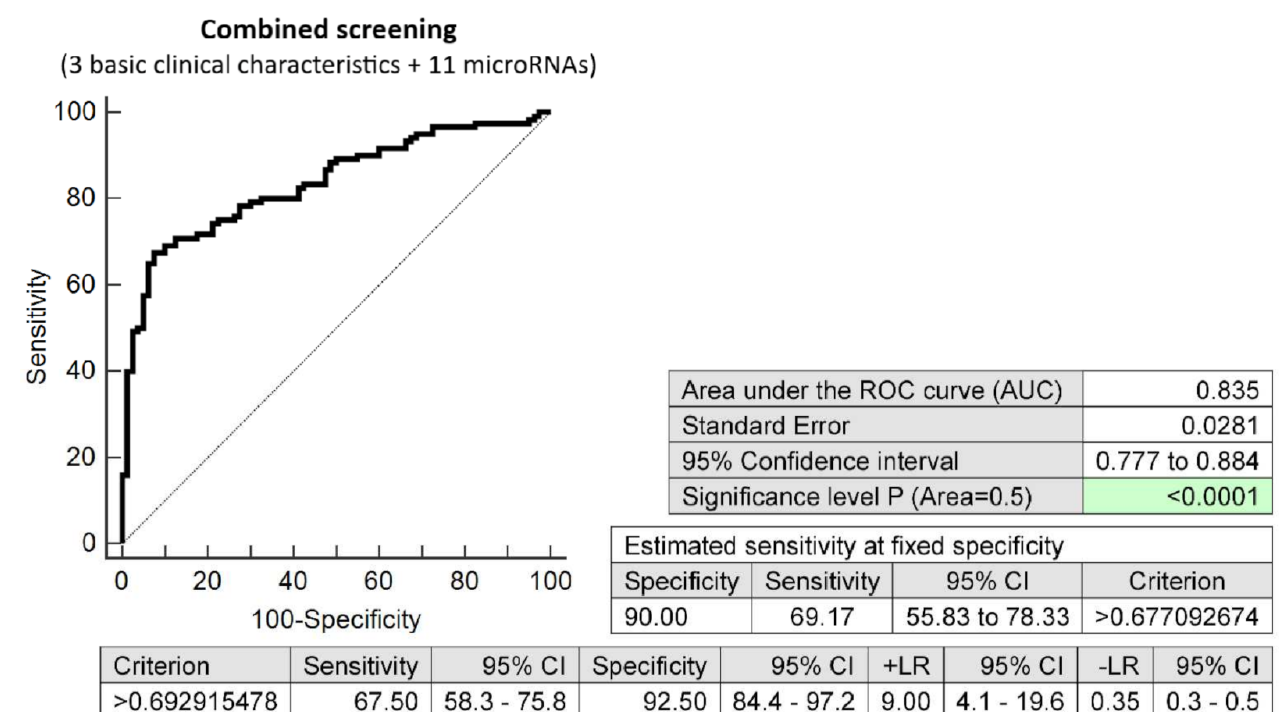
Figure 3. ROC analysis—the combination of 3 basic clinical characteristics (maternal age and BMI values at early stages of gestation and an infertility treatment by assisted reproductive technology) and 11 dysregulated microRNA biomarkers (miR-1-3p, miR-20a-5p, miR-20b-5p, miR-23a-3p, miR- 100-5p, miR-125b-5p, miR-126-3p, miR-181a-5p, miR-195-5p, miR-499a-5p, and miR-574-3p). At a 10.0% FPR, 69.17% of pregnancies destinated to develop GDM were identified during the first trimester of gestation. This represents 84 out of 121 pregnancies correctly predicted to develop GDM and 8 out of 80 normal pregnancies predicted false positively to develop